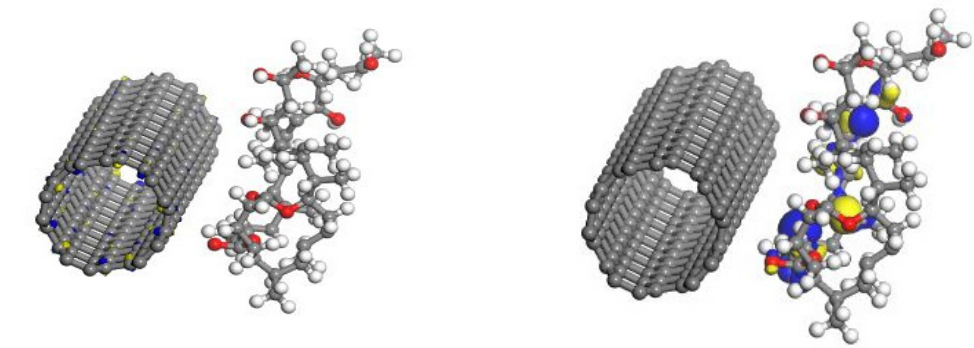
Figure 4. The frontier HOMO and LUMO orbitals of the mycolactone and its interaction with nanotubes. The isovalue of the isosurface is set as 0.03. ( B1 )—Mycolactone on a center of BNNT’s surface, ( B2 )—Mycolactone on the far end of the BNNT’s surface, ( C1 )—Mycolactone on the center of the CNT’s surface, and ( C2 )—Mycolactone on the far end of the CNT’s surface.